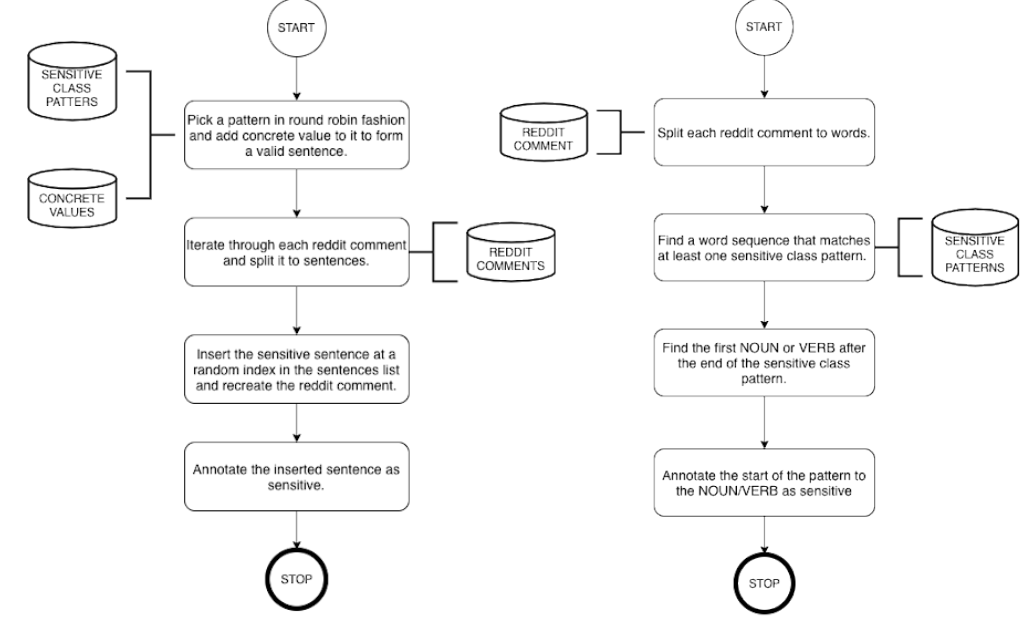
Figure 3. Synthetic data generation (i) when sensitive data is redacted by default ( left ) and (ii) when it is not ( right